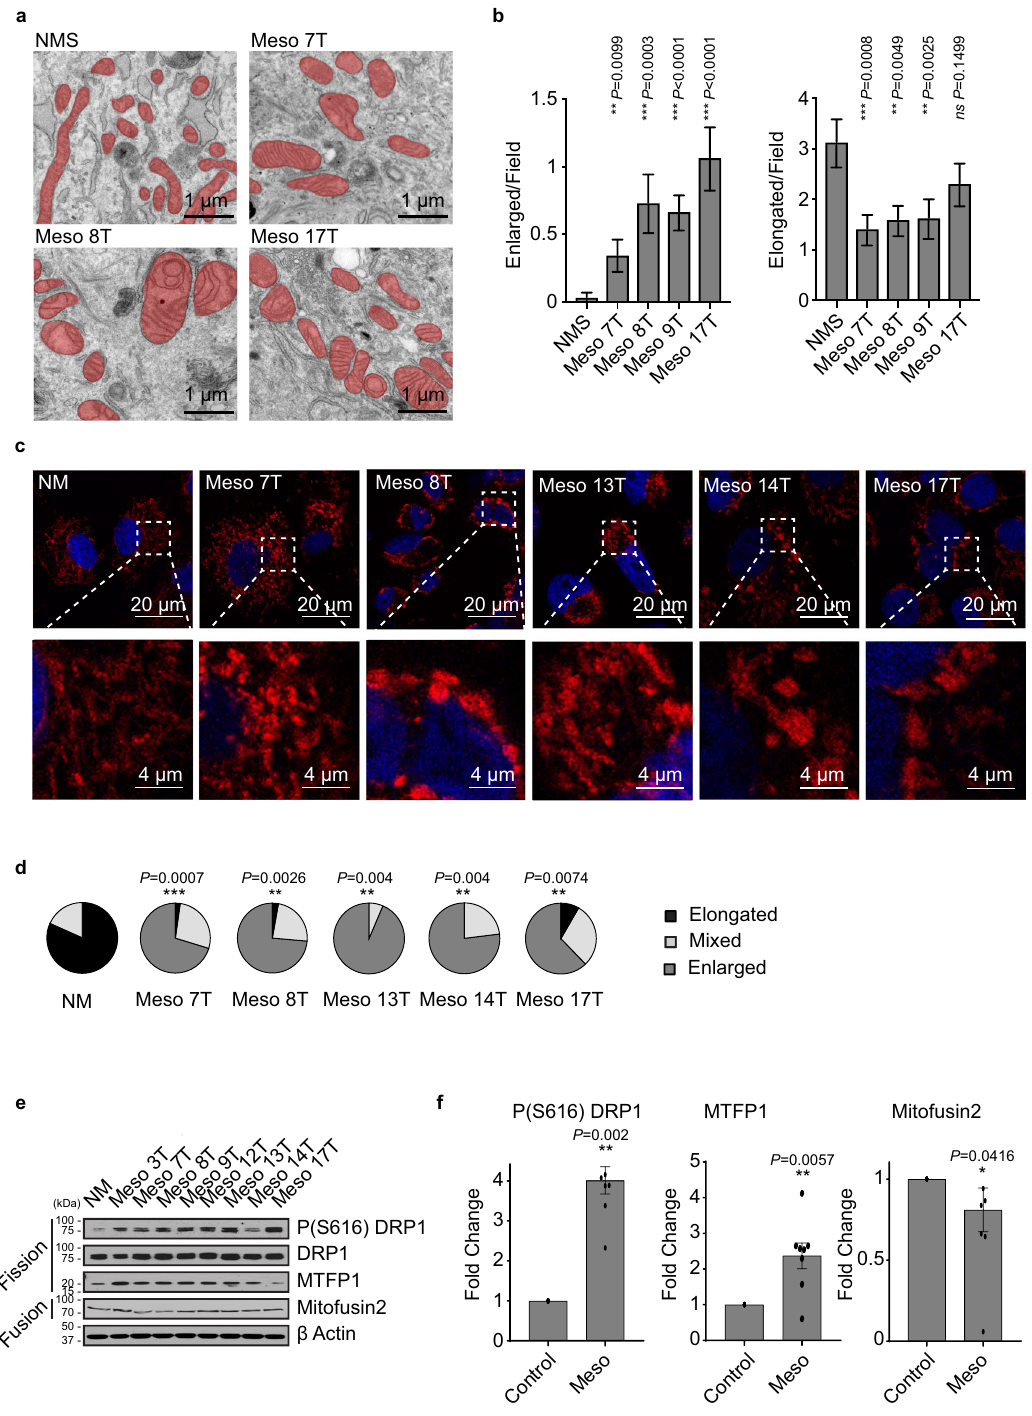
mitochondrial shape observed in confocal and electron microscopy. Metabolic changes in aberrant MpM-derived mitochondria provide energy and metabolites for tumour cell growth . To assess whether the differences in mitochondrial shape and net- work in MpM are associated with alterations in oxidative phos- phorylation, oxygen consumption rate (OCR) was measured (Fig. 4a). The data show that basal (Fig. 4b) and maximum OCR